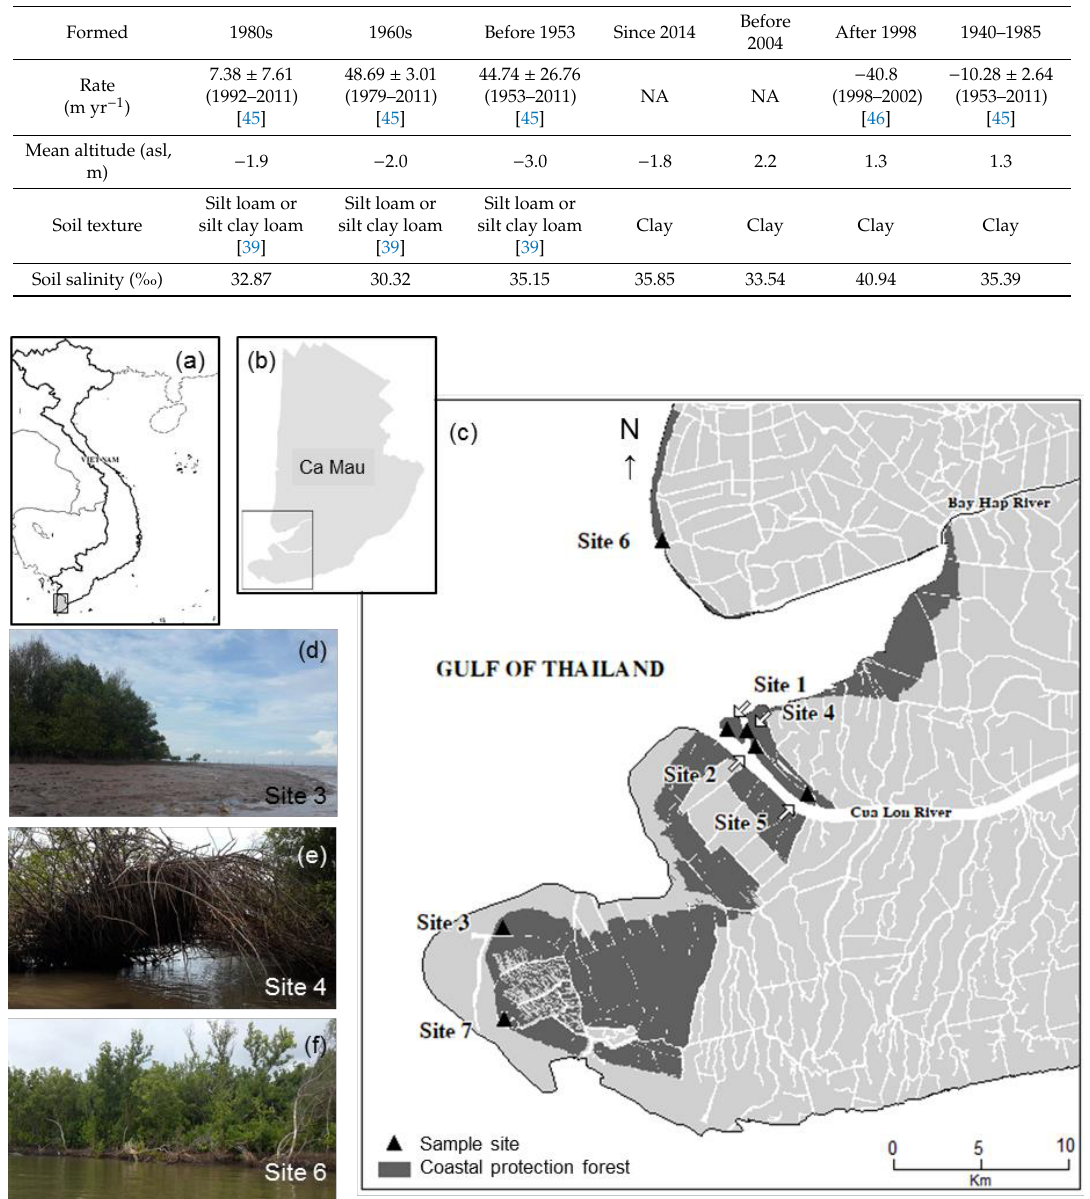
Figure 1. Map of ( a ) Vietnam, ( b ) Ca Mau province, and ( c ) the study site distribution as described in Table 1. Photos of ( d ) accretion and ( e , f ) erosion sites.